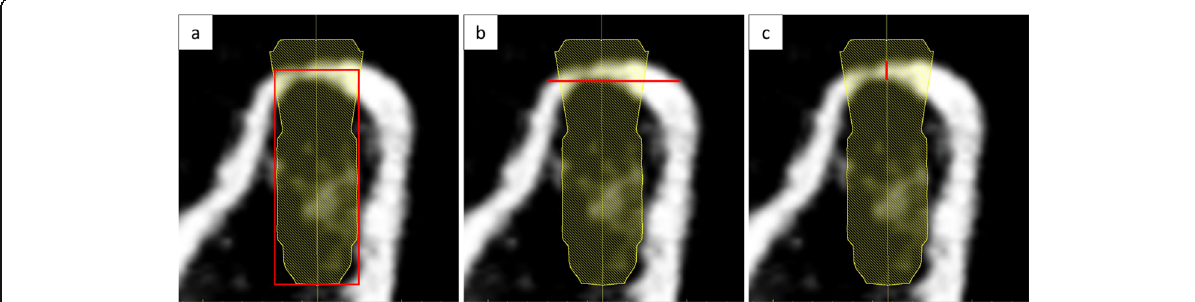
Fig. 1 Bone condition analysis. a Bone density measurement. Red box indicates the measured area with an implant outer area as a reference. b Bone width measurement. Red bar indicates the measured area at 1 mm under the crest of alveolar bone. c Cortical bone thickness measurement. Red bar indicates the measured area parallel to the dental implant axis